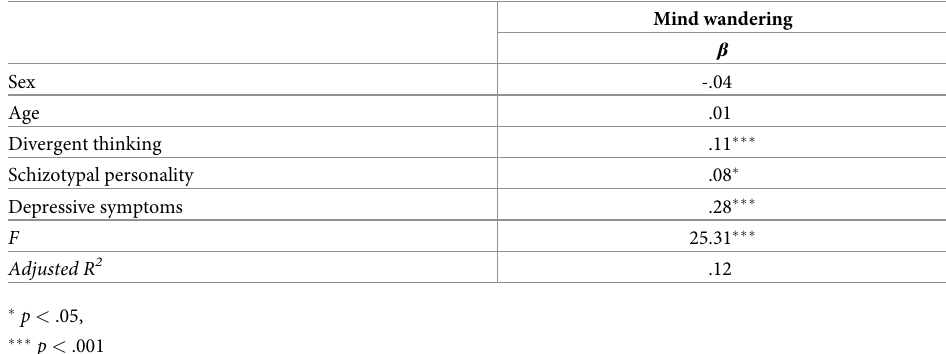
Table 3. Results of multiple regression analysis using mind wandering, divergent thinking, and mental